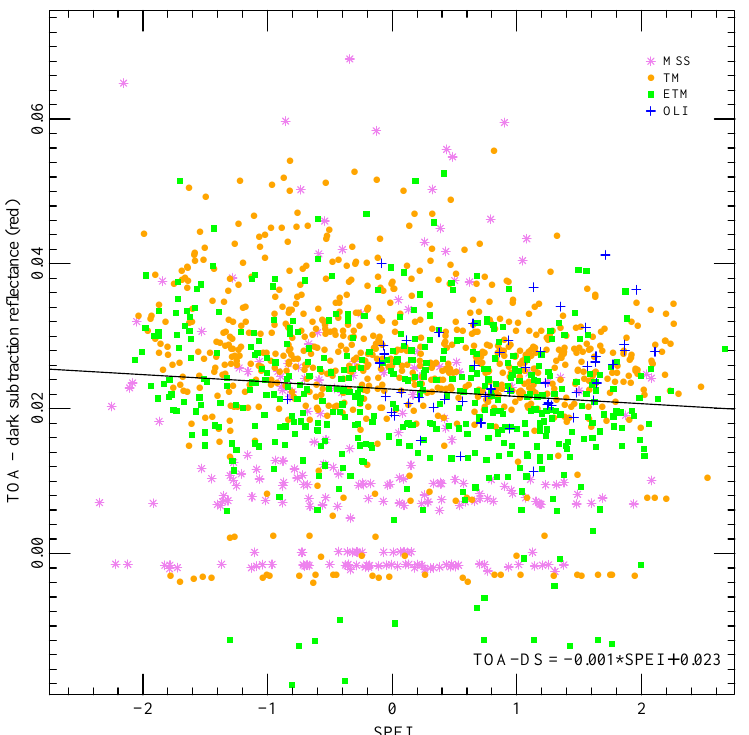
Figure A3. Comparison between SPEI and the dark subtraction (DS) correction (TOA minus dark subtraction reflectance) for the red band. Spot checks suggest that dark correction values near zero are often due to data artifacts in the Landsat observations. The black line shows the linear regression, equation ( − 0.0010 ± 0.0003 ) × SPEI + ( 0.0227 ± 0.0003 ) , with p <